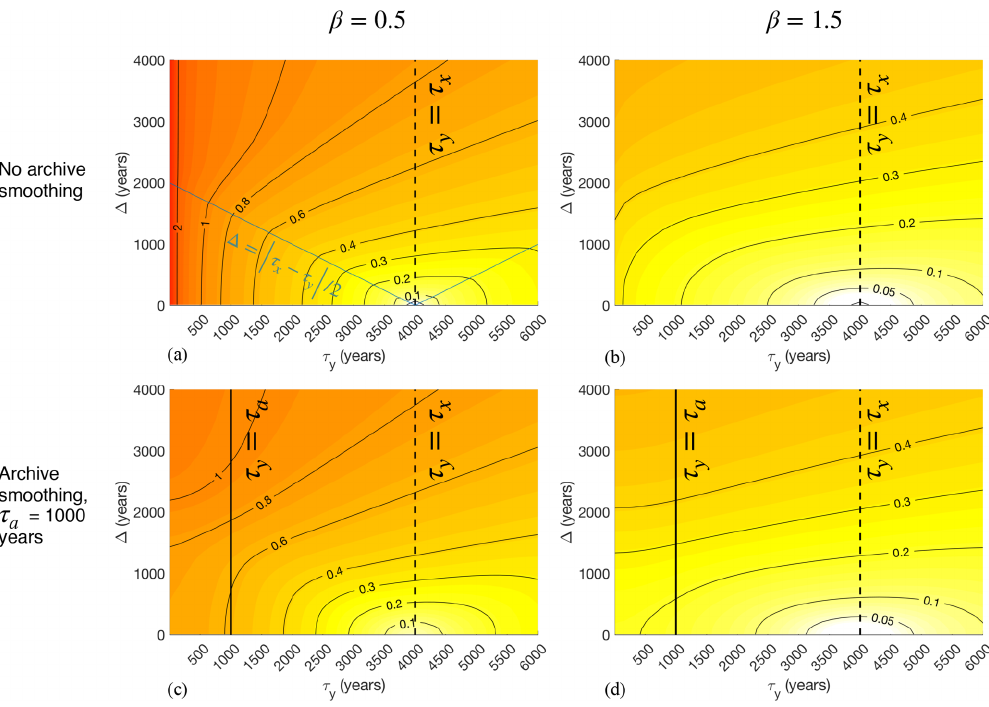
Figure 6. Same as Fig. 5, but illustrating the effects of offsets (cid:49) between target and observational intervals on noise-to-signal ratios. In all cases, the target averaging interval is τ x = 4000, reflecting the nominal length of the Last Glacial Maximum. Values along the line τ y = τ x strictly reflect the influence of chronological offsets. The blue line in panel (a) denotes values for which (cid:49) = maximum values of (cid:49) for which the observation interval lies completely within the target